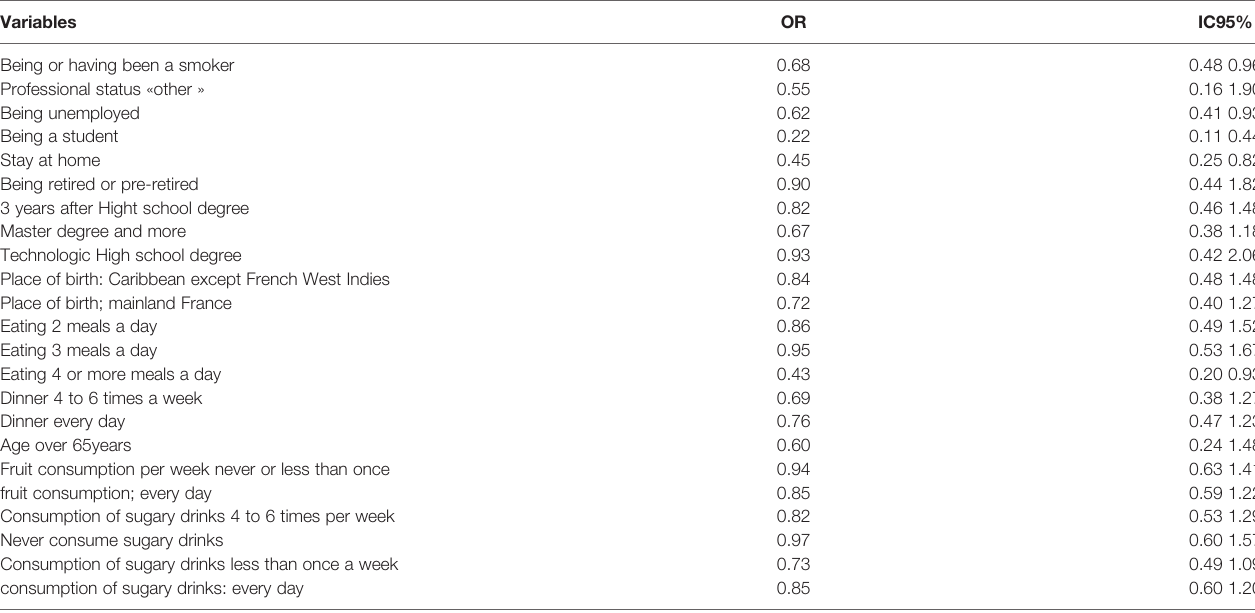
TABLE 5 | Logistic regression results (OR<1).